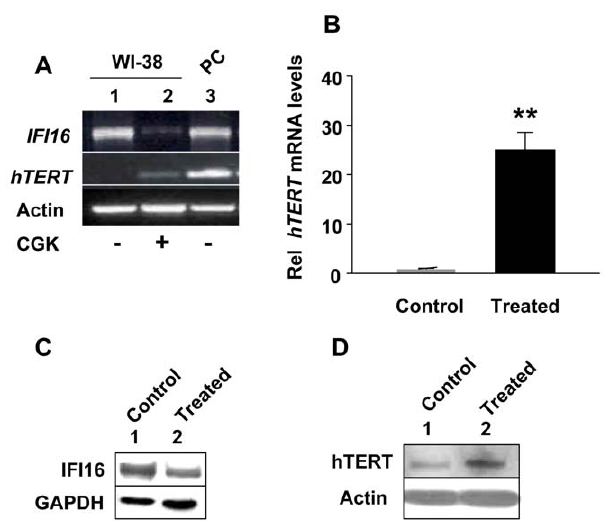
Figure 2. Reduced expression levels of IFI16 protein in human normal diploid fibroblasts after treatment with histone deacetylase inhibitor are associated with increased expression of hTERT and increased telomerase activity. ( A ) Total RNA isolated from untreated (control, lane 1) or CGK1026 (10 m M for 24 h, lane 2) treated young WI-38 fibroblasts was subjected cDNA synthesis followed by semi-quantitative PCR using a pair of primer specific to the IFI16 , hTERT , or actin. As a positive control, we used RNA from human HT1080, a human fibrosarcoma cell line. ( B ) Total RNA isolated from untreated (control) or CGK1026 (10 m M for 24 h; treated) treated young WI-38 fibroblasts was subjected cDNA synthesis, followed by quanti- tative real-time PCR using the TaqMan assay for the hTERT gene. Results are mean values of triplicate experiments and error bars represent standard deviation ( ** p , 0.005 ). ( C and D ) Total protein extracts prepared from untreated (lane 1) or CGK1026 (10 m M for 24 h; treated) treated young WI-38 fibroblasts were subjected to immunoblotting